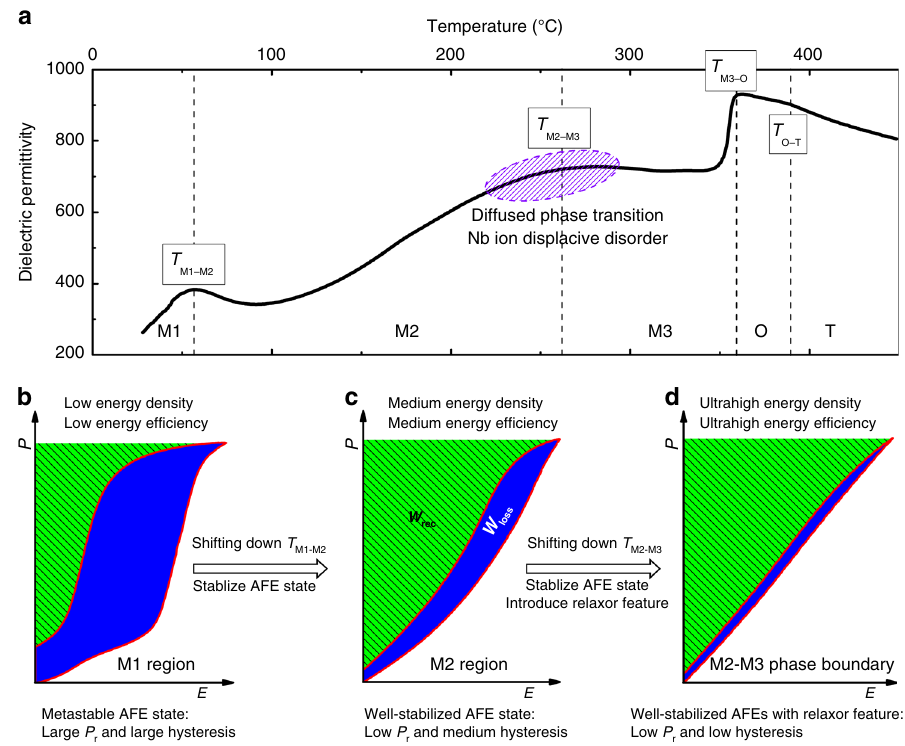
Fig. 1 Designing principles of high energy storage performance AN-based materials. a Temperature dependence of the dielectric permittivity of AN with a series of phase transitions. The T M1-M2 stands for M1 – M2 phase transition temperature. Schematic diagram of P – E loops for energy storage of b a metastable AFEs with phase in M1 region, c fully stabilized AFEs with phase in M2 region, d fully stabilized AFEs with relaxor characteristics around M2 – M3 phase boundary where a diffused phase transition can be observed.